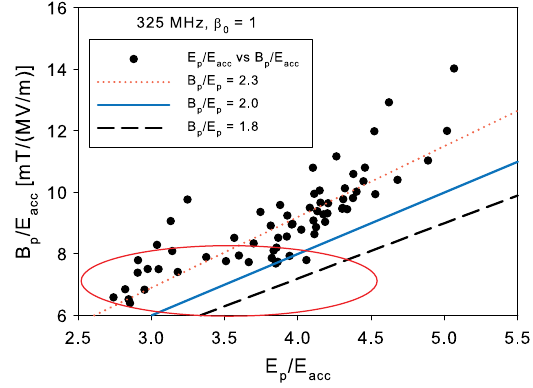
FIG. 10. B p =E acc vs E p =E acc for various spoke base shapes. Those shapes within the circled region are candidates for further investigation.